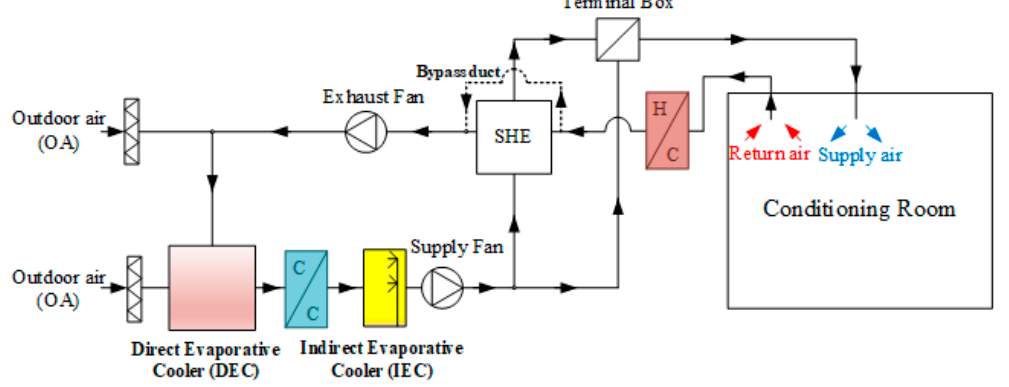
Figure 4. The schematic of IDECOAS.